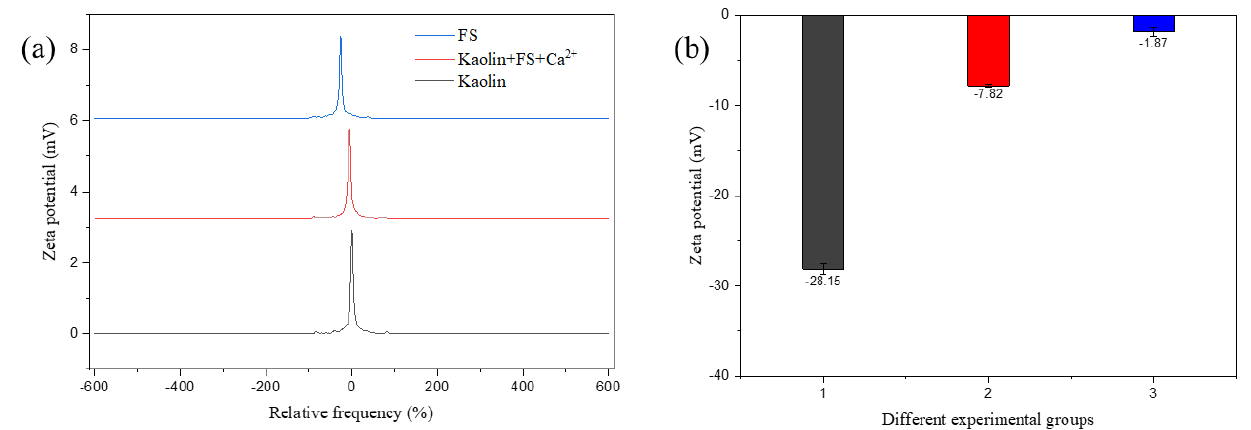
Figure 11. Zeta potentials of kaolin, kaolin + FS + Ca 2+ , and FS, respectively. Black solid lines and columns represent kaolin; red solid lines and columns represent kaolin + FS + Ca 2+ ; and blue solid lines and columns represent the potential of FS, respectively. ( a ) Zeta potential frequency diagram ( b ) Zeta potential in different experimental groups.